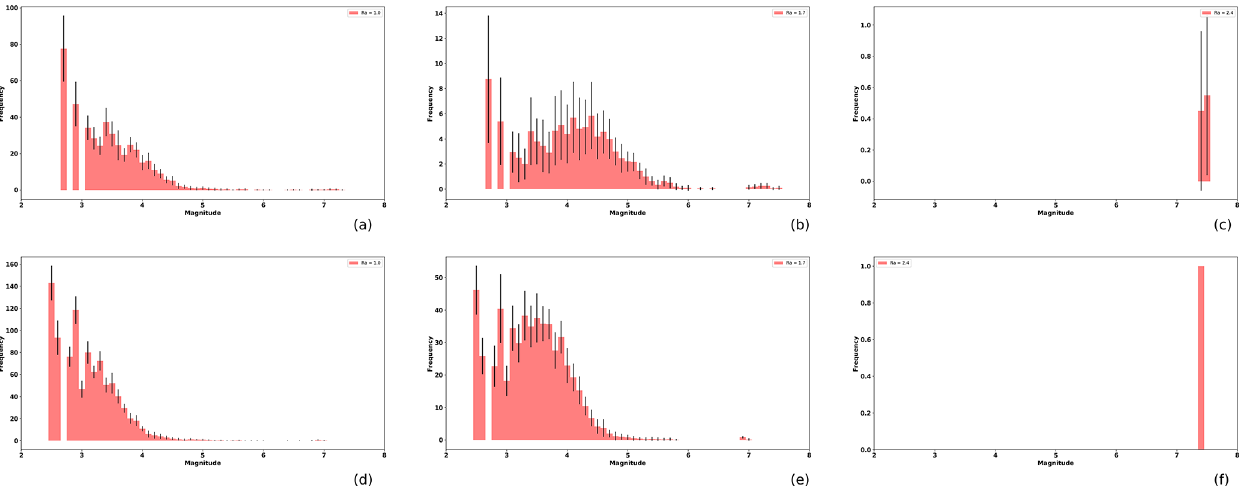
Figure A1. Magnitude histograms as a function of the ratio size R a (from left to right R a = 1 . 0, 1.7, 2.4, respectively), and the effective area of 40000 cells and 90000 cells, for upper and lower rows respectively. The bars shows the mean histogram, and the error bars depict the standard deviation of the 20 realizations.